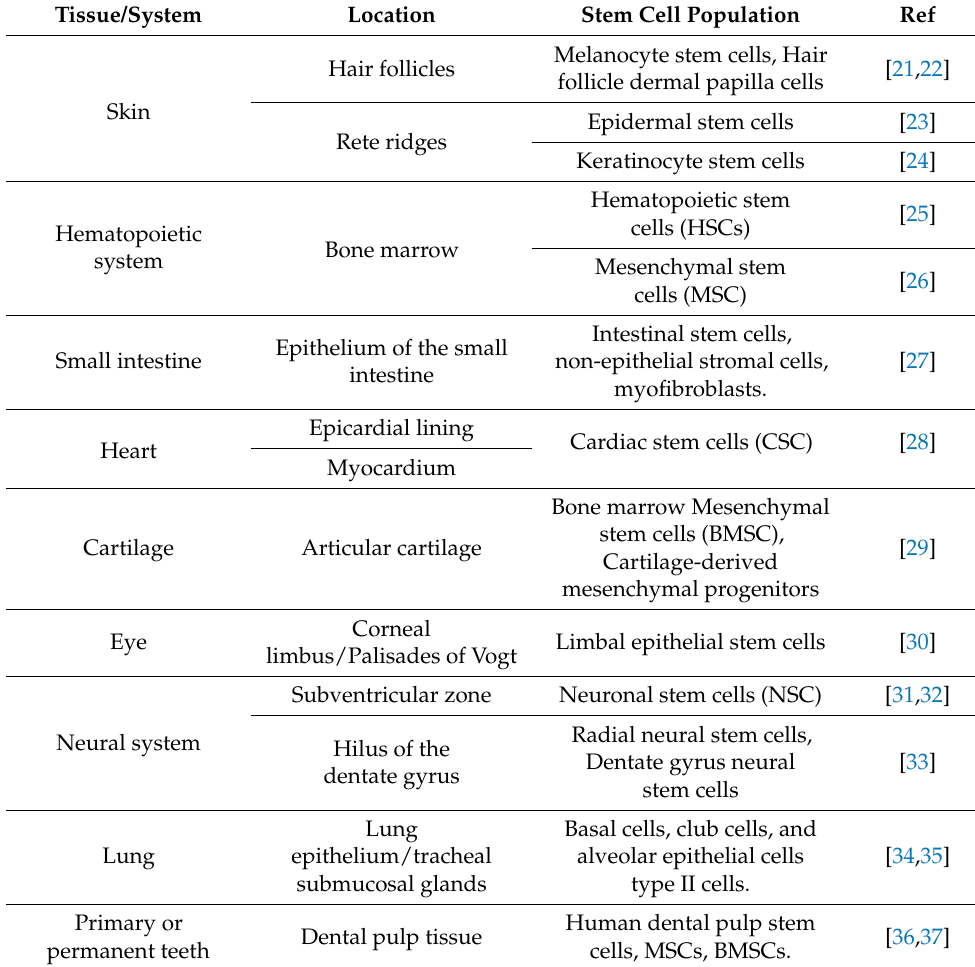
Table 1. Stem cell niches which have been studied for their potential to improve tissue regeneration by controlling stem cell